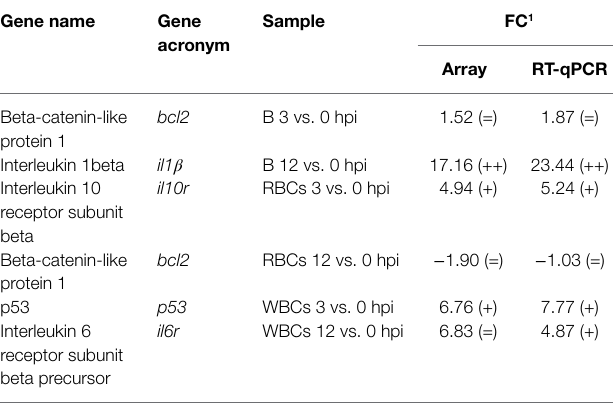
TABLE 1 | Microarray validation by